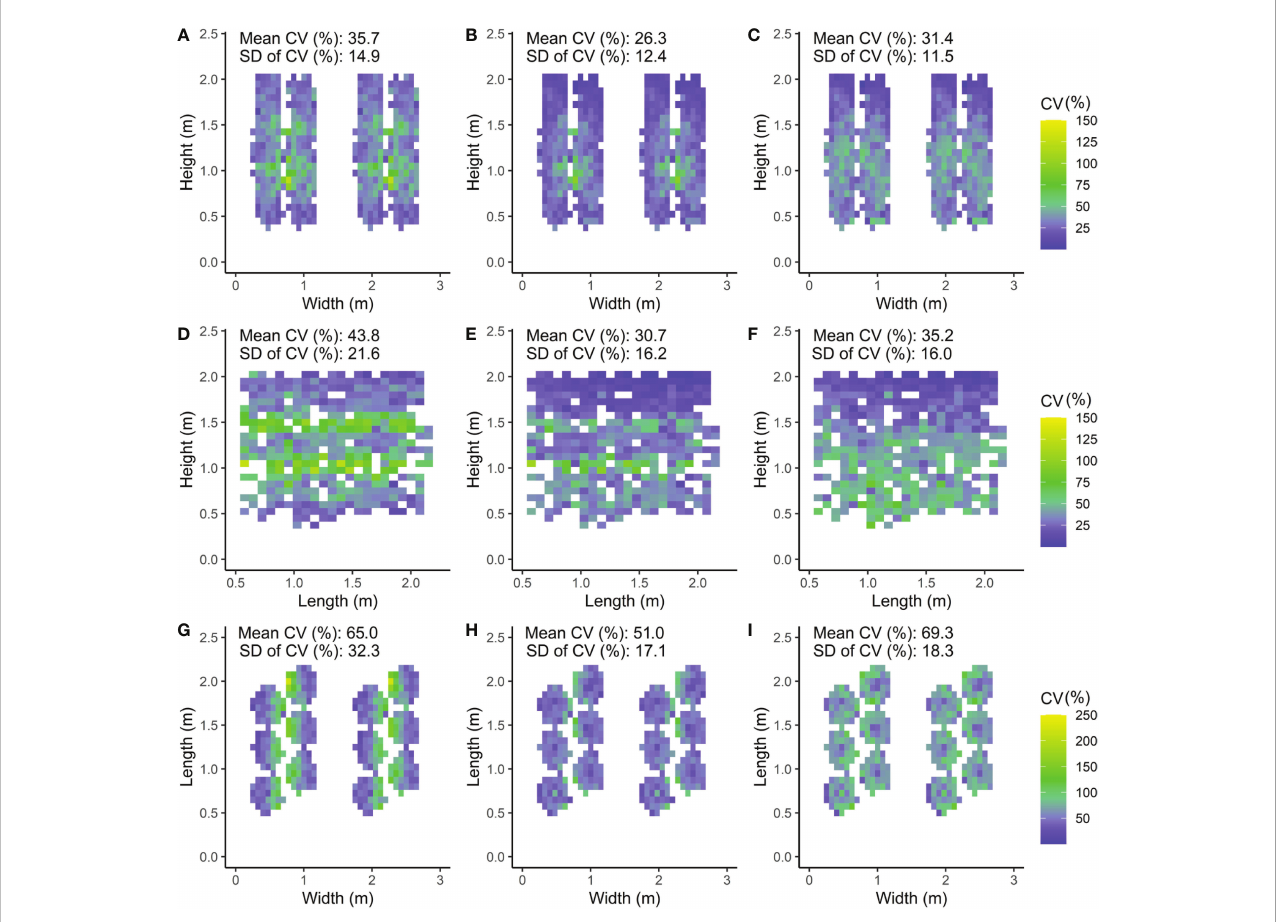
FIGURE 6 Front (A – C) , side (D – F) and top views (G,H,J) of the canopy with the CV (coef fi cient of variation) calculated as the standard deviation (SD) of the absorbed PPFD divided by the mean absorbed PPFD of the lea fl ets within the voxel times 100%. Three LED lamp positions are compared; (A, D, G) intra- canopy lighting, (B, E, H) combined intra-canopy and top lighting, and (C, F, I) top lighting. Each voxel had the dimensions of 7.5 cm width and length and a depth reaching 6 plants in each row (A – C) , 8 plants across four double rows (D – F) or whole plant height (G – I) . In A – C, a front view of the canopy is shown in which the CV value represents the heterogeneity of the voxel oriented parallel to the row. In D – F, a side view of the canopy is shown in which the CV value represents the heterogeneity of the voxel oriented perpendicular to the row. In G – I, a top view of the canopy is shown in which the CV value represents the heterogeneity of the voxel oriented vertical. Plants are spaced at 0.5m within each row in a double row. For visual interpretation of the distance between rows in the canopy an additional replicate double row is shown in A – C , G – I for which the same values were used as in the other